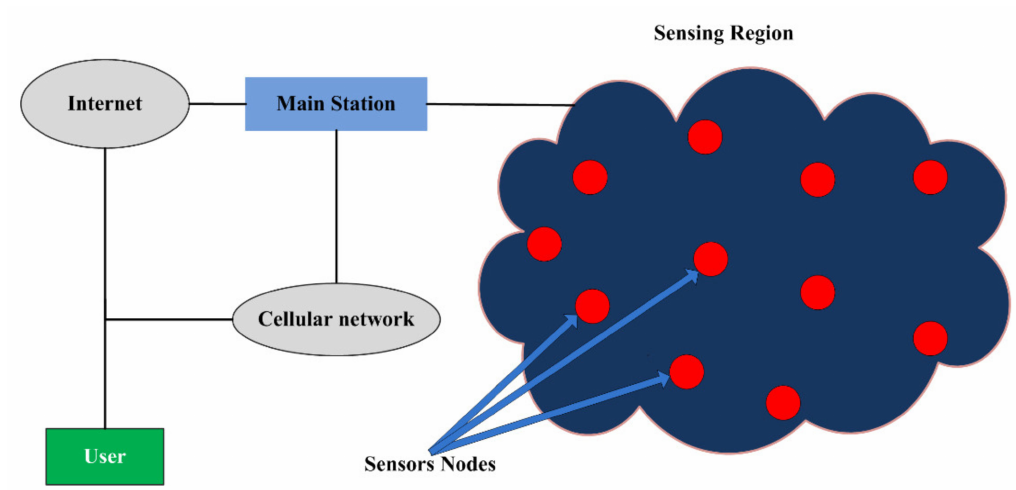
Figure 1. A typical block diagram of WSN.